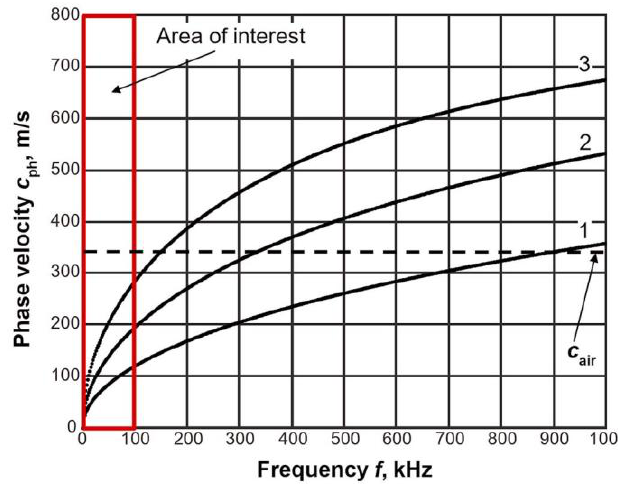
Figure 1. The dispersion curves of the Lamb wave A 0 mode in PVC films of different thicknesses d : 1— d = 0.05 mm; 2— d = 0.135 mm; 3— d = 0.3 mm. The dashed line indicates the ultrasound velocity in air ( c air = 342 m/s).